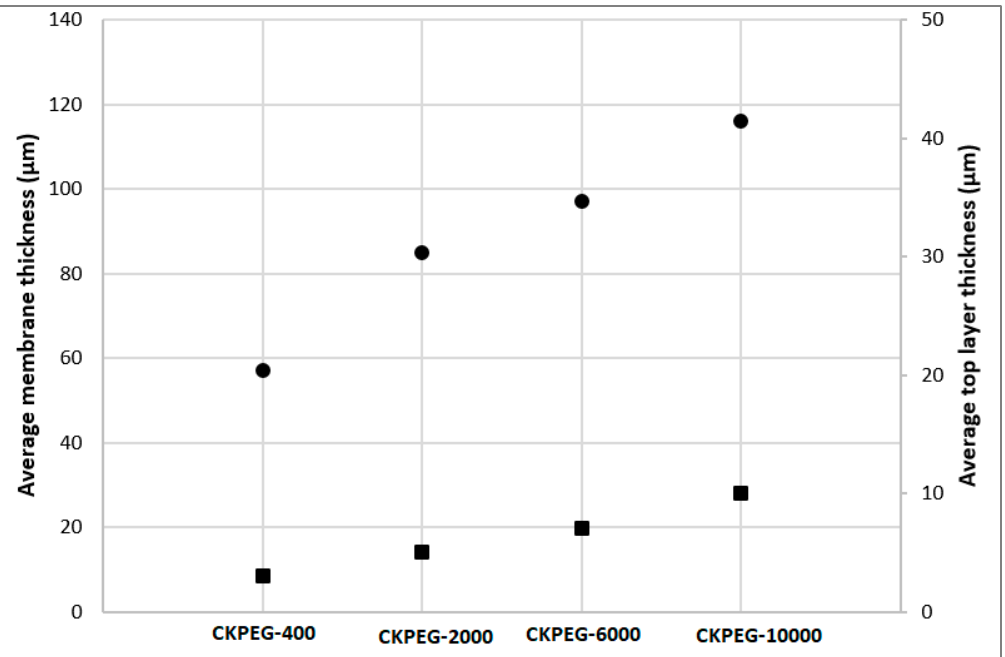
Figure 4. Variation of the average total membrane ( • ) and sponge-like top layer ( (cid:4) ) thickness with PEG Mw.